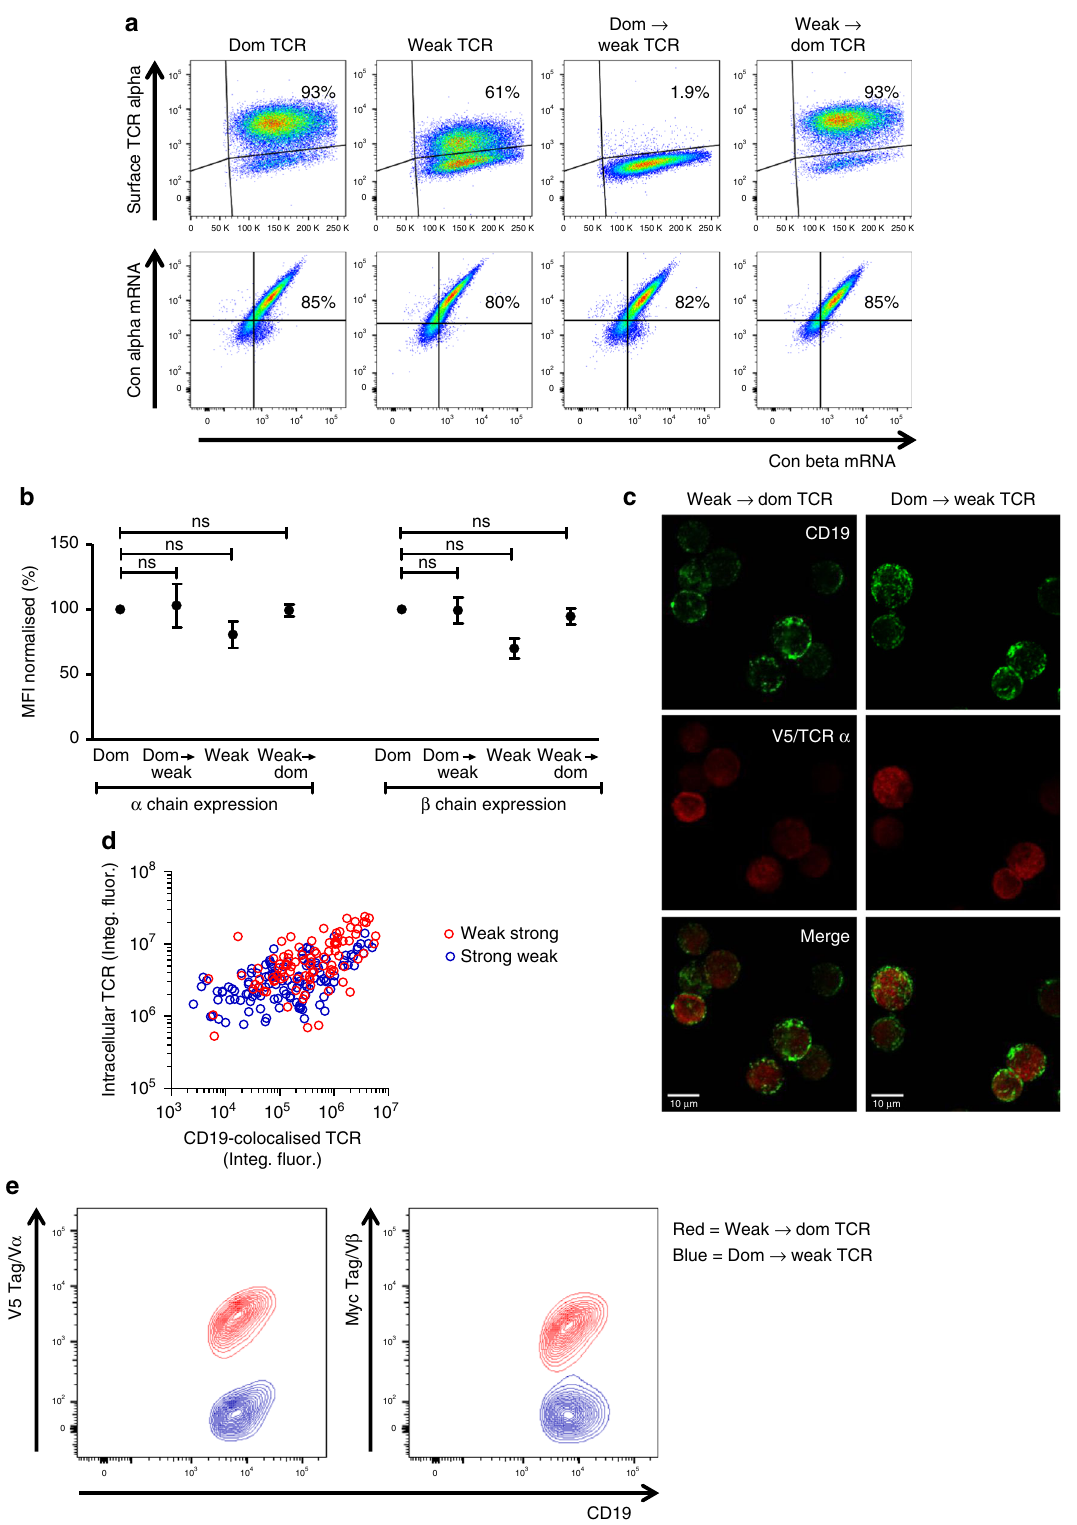
arginine and tyrosine at positions 9 and 10 of the β -chain residues with more subtle effects on TCR expression. In order to (Supplementary Table 1). Moreover, a number of additional explore this, we have used next generation sequencing to generate amino acid residues were signi fi cantly more frequent in the large libraries containing more than 130,000 α / β TCR clonotypes dominant TCR library compared with the weak TCR library. with dominant and weak expression phenotypes. Bioinformatic However, it seems likely that the role of these additional residues analyses of these large TCR libraries con fi rmed the importance of is relatively subtle, because the LRY modi fi cation alone was hydrophobic residues at position 96 of the α -chain, and of NATURE COMMUNICATIONS| (2019) 10:4451